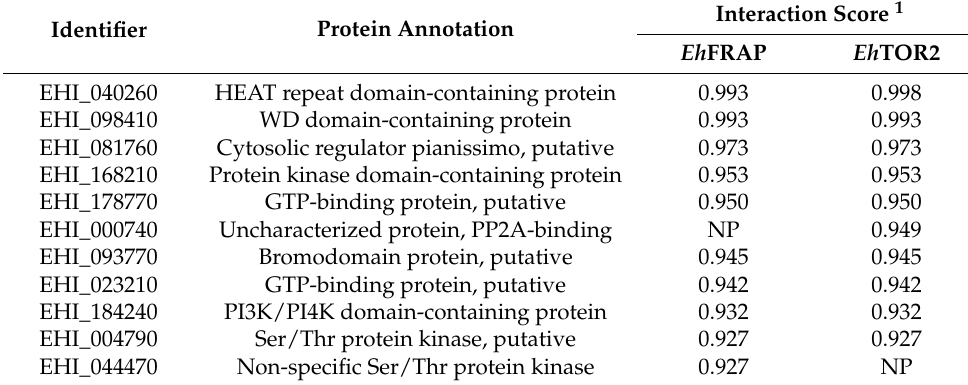
Table 3. PPI networks predicted by STRING for Eh FRAP and Eh